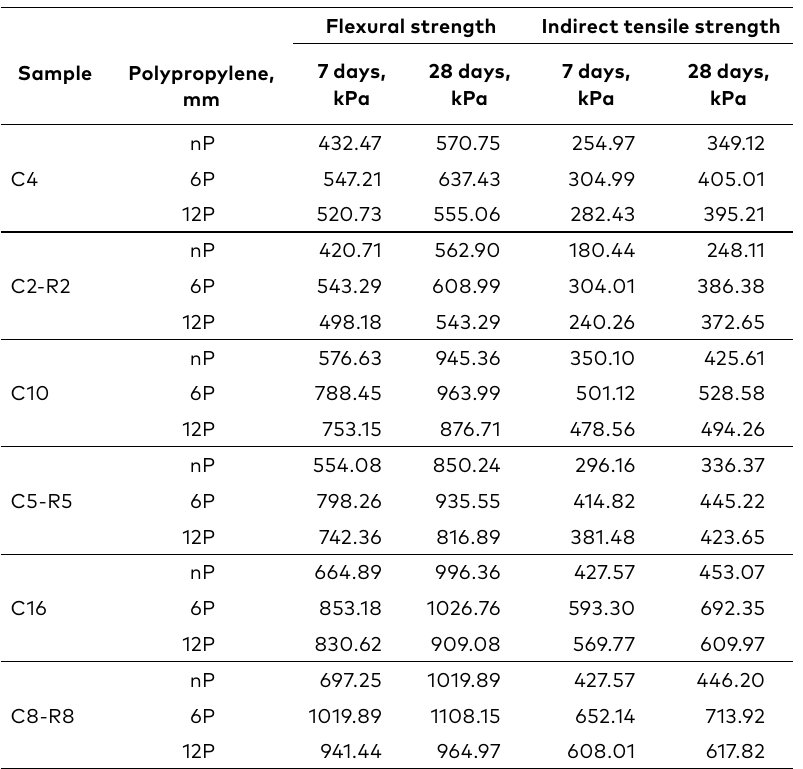
Table 5. Flexural strength and indirect tensile strength values of both 7 days and 28 days cured